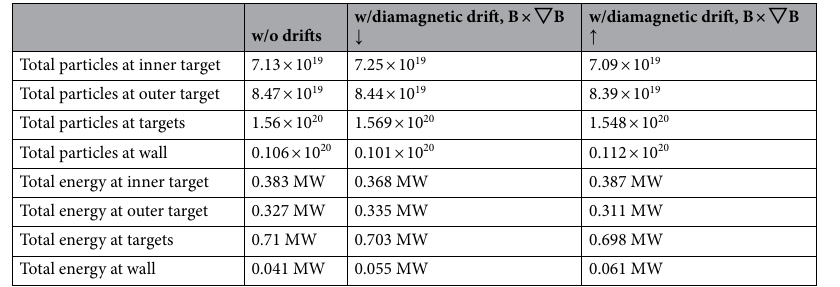
Table 1. Total particles and energy to the inner and outer divertor targets for case without drifts and cases with only diamagnetic